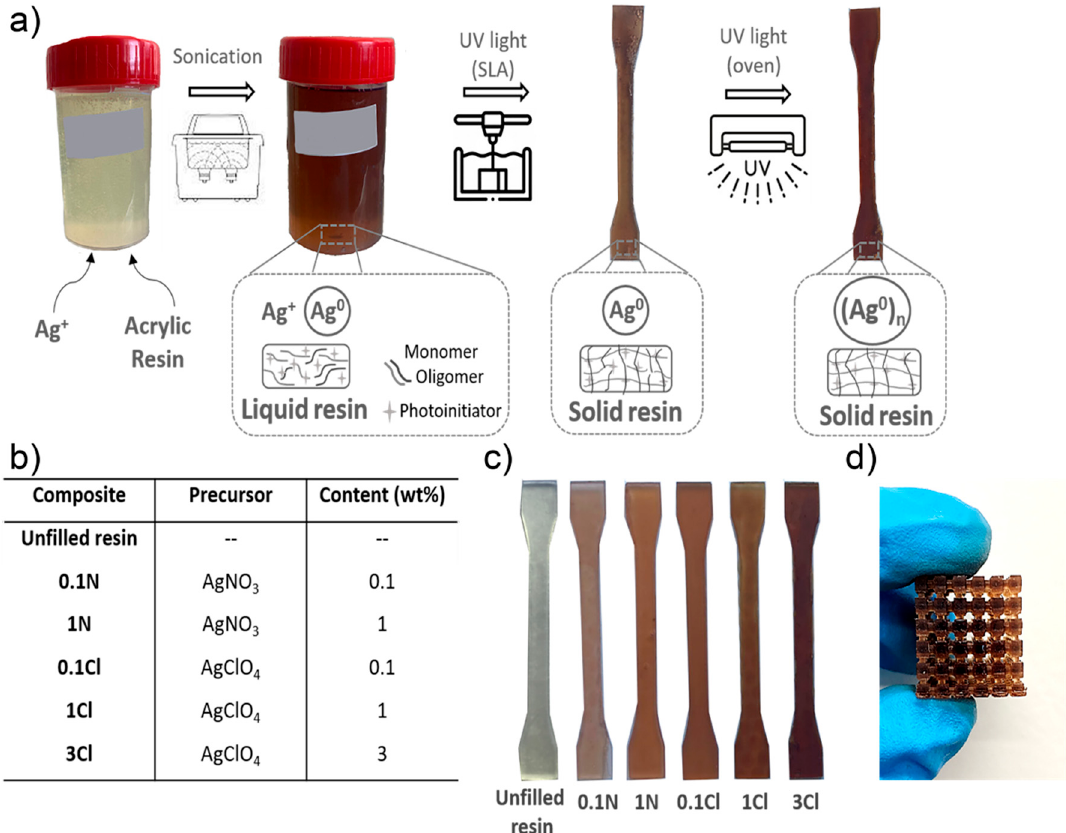
Figure 1. ( a ) Scheme depicting the fabrication of the nanocomposite printed objects using SLA; ( b ) table defining the nanocomposite solutions; ( c ) 3D printed parts of the different nanocomposites: from left to right, unfilled resin, 0.1N, 1N, 0.1Cl, 1Cl and 3Cl; ( d ) 3Cl object printed by SLA.